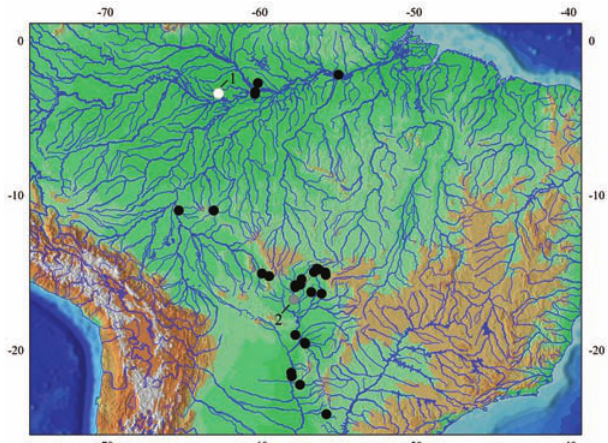
Fig. 6. Map of northern South America showing distribution of Hemigrammus lunatus : (1) the white circle represents the type locality of Hemigrammus lunatus , (2) the gray circle represents the type locality of Hyphessobrycon maxillaris , and black circles represent remaining localities of analysed material in the present